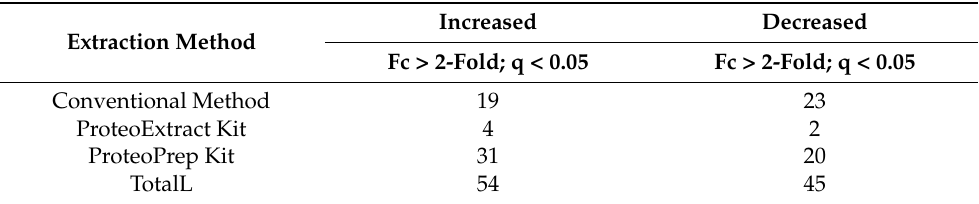
Table 1. Increased and decreased abundance proteins in the membrane versus cytosolic fractions (q < 0.05) by three different methods.